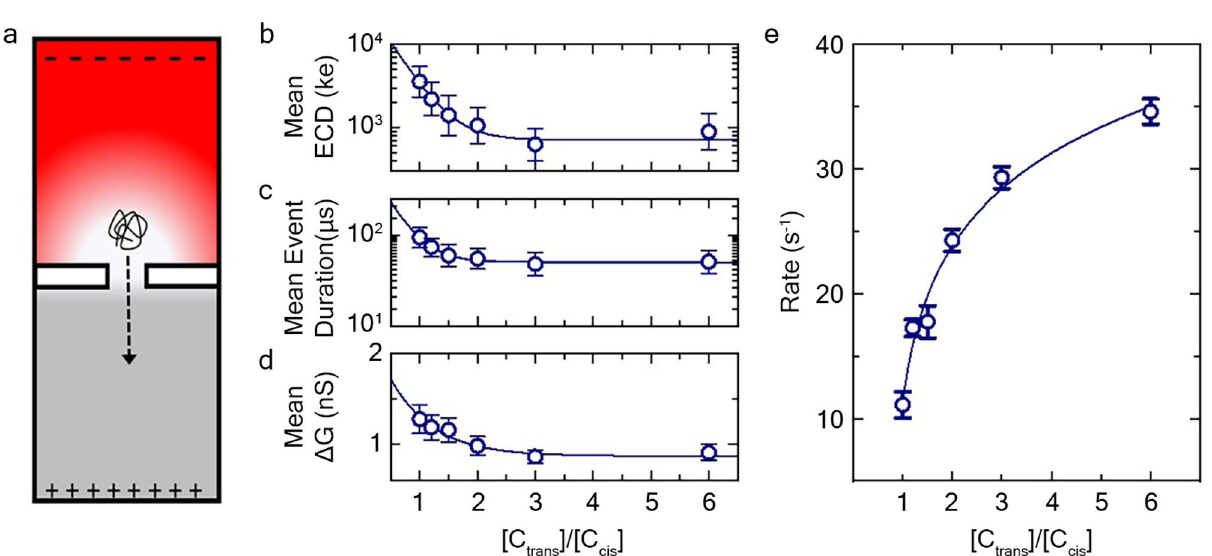
Figure 5. ( a ) Schematic representation of electric field across a SS-nanopore under asymmetric salt conditions (dash arrow indicates movement of HA molecule from cis - to trans -chamber). Translocation results under varying LiCl asymmetry where C trans is kept at 6 M and C cis is varied from 1 to 6 M, showing mean ECD ( b ), event duration ( c ), and conductance change ( d ). Solid lines are exponential fits to the data. ( e ) Event rate across asymmetric buffer conditions [C trans :C cis ] LiCl. Solid line is a logarithmic fit to the data. All measurements were taken at an applied voltage of 200 mV using quasi-monodisperse 237 kDa HA samples prepared at a 2.5 ng/µL concentration. Results collected using SS-nanopores 7–9 nm in diameter representing at least 1000 events for each data point. Error bars represent measurement standard